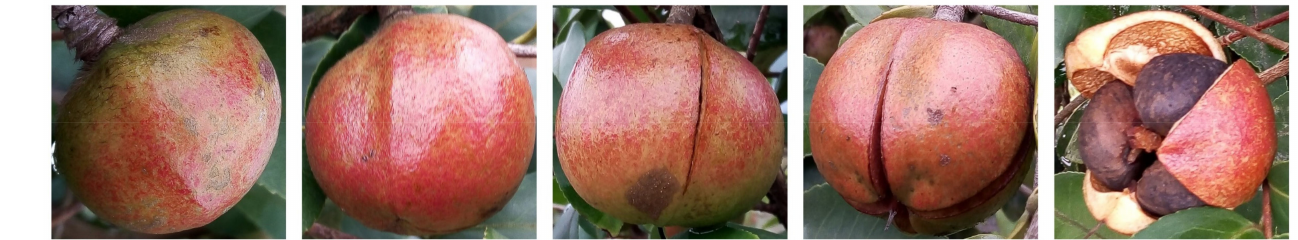
Figure 1. Images example of Camellia oleifera fruit.